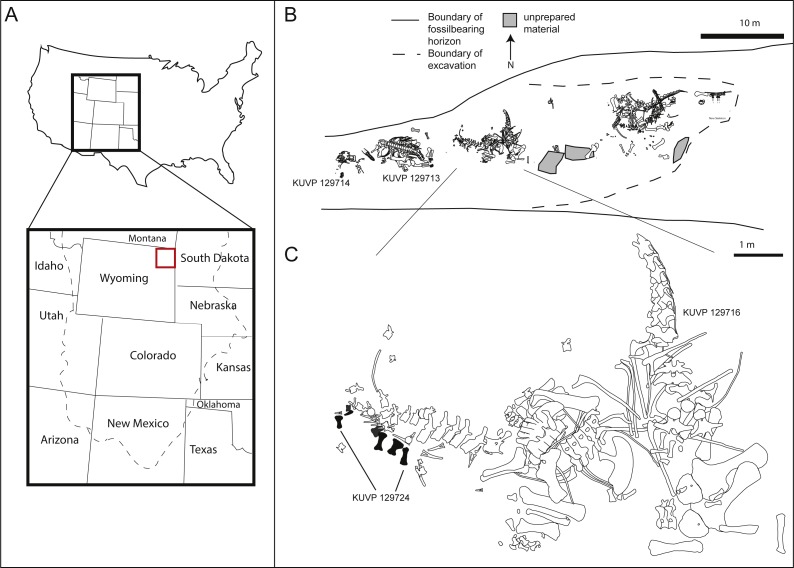
Location (A) and quarry maps (B, C) of Bobcat Pit in Weston County, Wyoming.The astragalus and pes described herein (KUVP 129724, 133862, 142200, 144767) were found associated with the Camarasaurus skeletons KUVP 129713 and 129716. Quarry maps modified from Bader, Hasiotis & Martin, 2009: figs 2, 4.